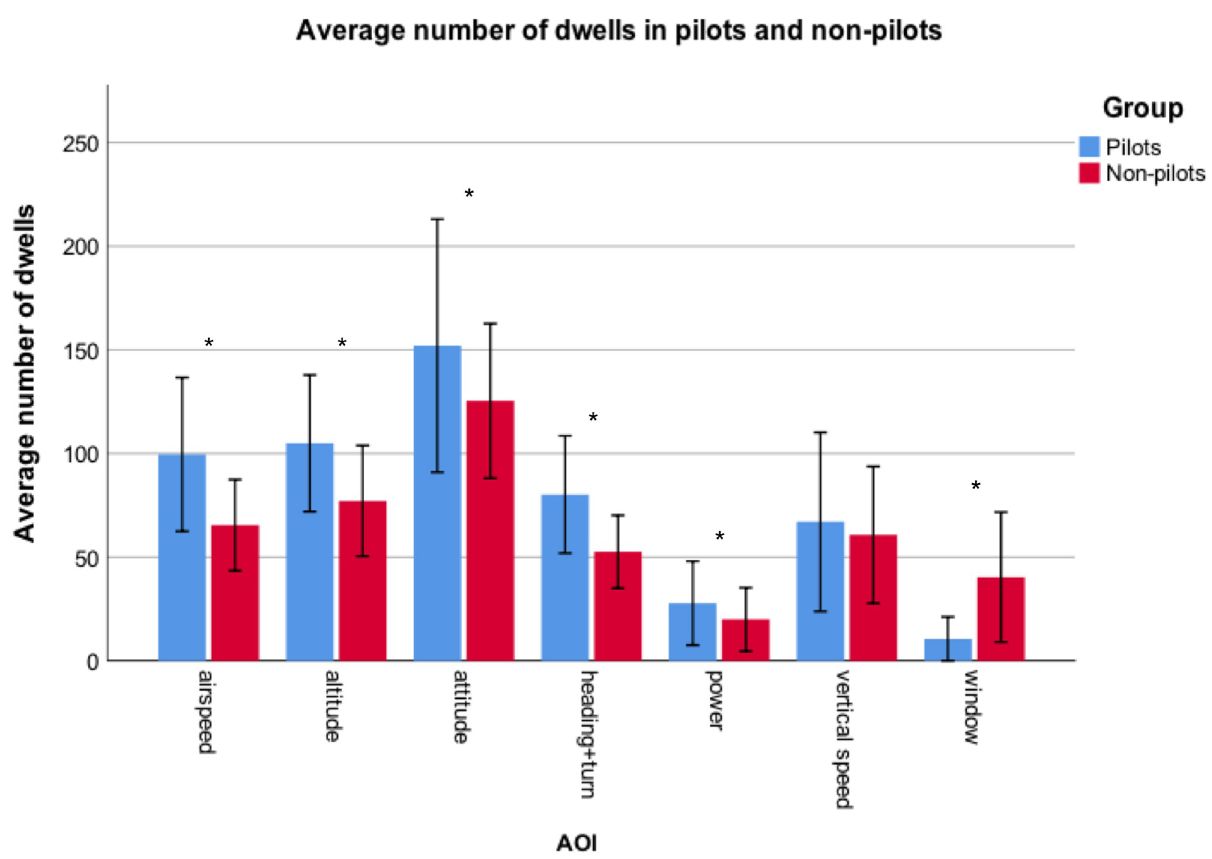
Fig 3. Comparison of the mean number of dwells between pilots and non-pilots (error bars represent SD and � indicates p < .05).